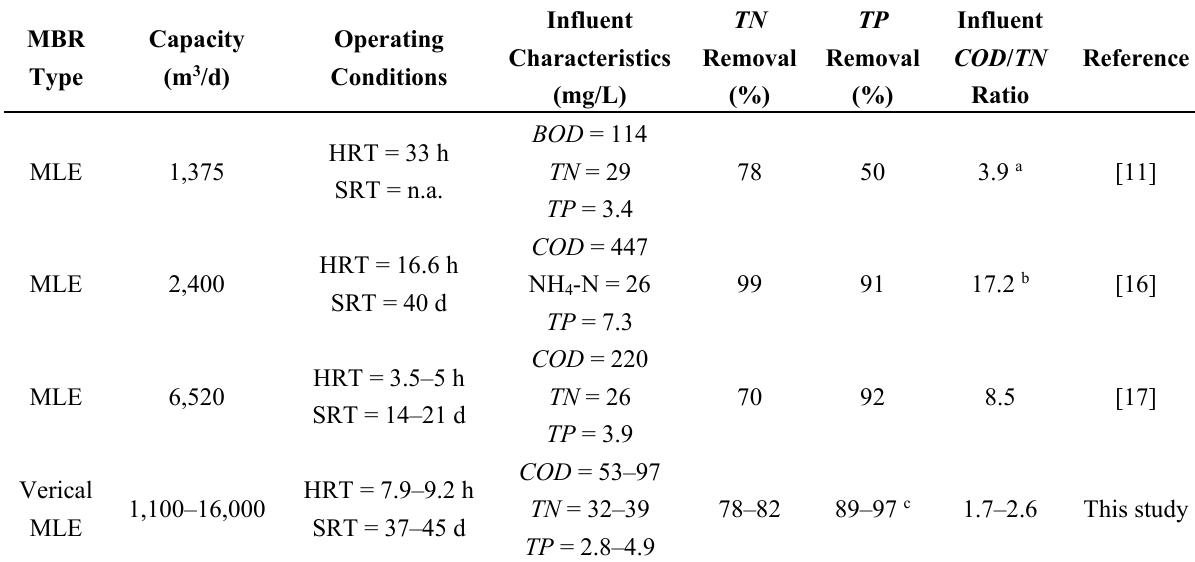
Figure 3. Progress of membrane fouling in a field-scale DMBR TM system (Dangjin-si (A), South Korea). Table 3. Performance of various submerged membrane bioreactor (MBR) systems treating municipal